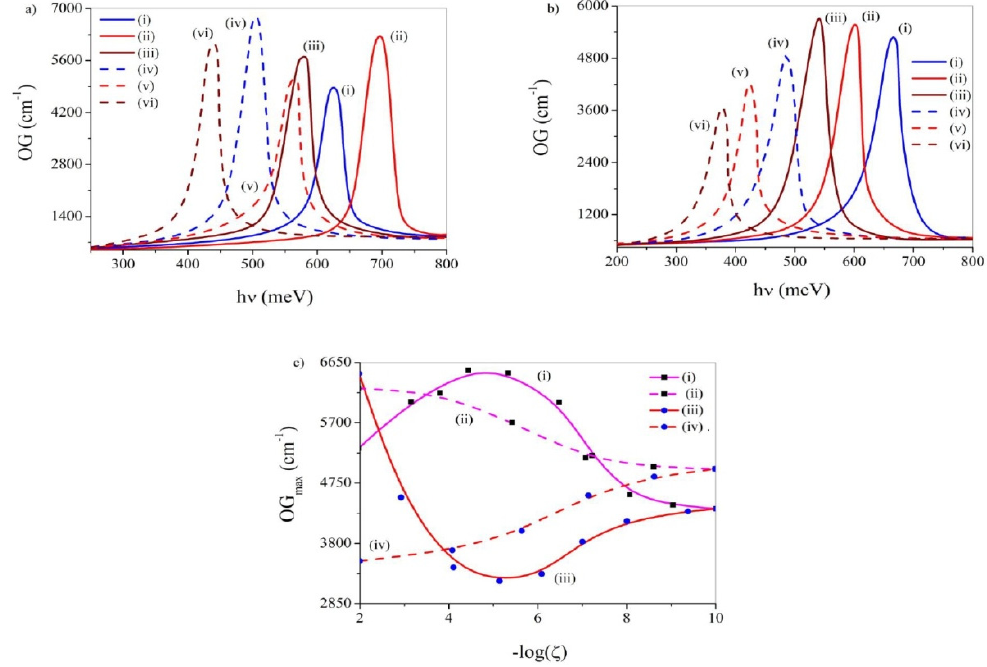
Figure 20. OG vs. h υ diagrams with ( a ) OPA and ( b ) EPA. In these diagrams (i) ADWN and ζ = 10 − 10 , (ii) ADWN and ζ = 10 − 6 , (iii) ADWN and ζ = 10 − 2 , (iv) MLWN and ζ = 10 − 10 , (v) MLWN and ζ = 10 − 6 , (vi) MLWN and ζ = 10 − 2 . ( c ) Depiction of OG peak vs. − log( ζ ): (i) with ADWN and OPA, (ii) with ADWN and EPA, (iii) with MLWN and OPA and (iv) with MLWN and EPA.